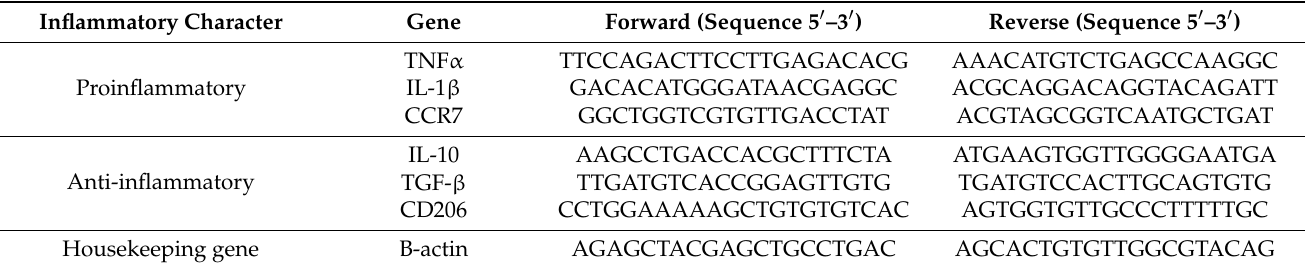
Table 4. Sequences of primers used for quantitative real time polymerase chain